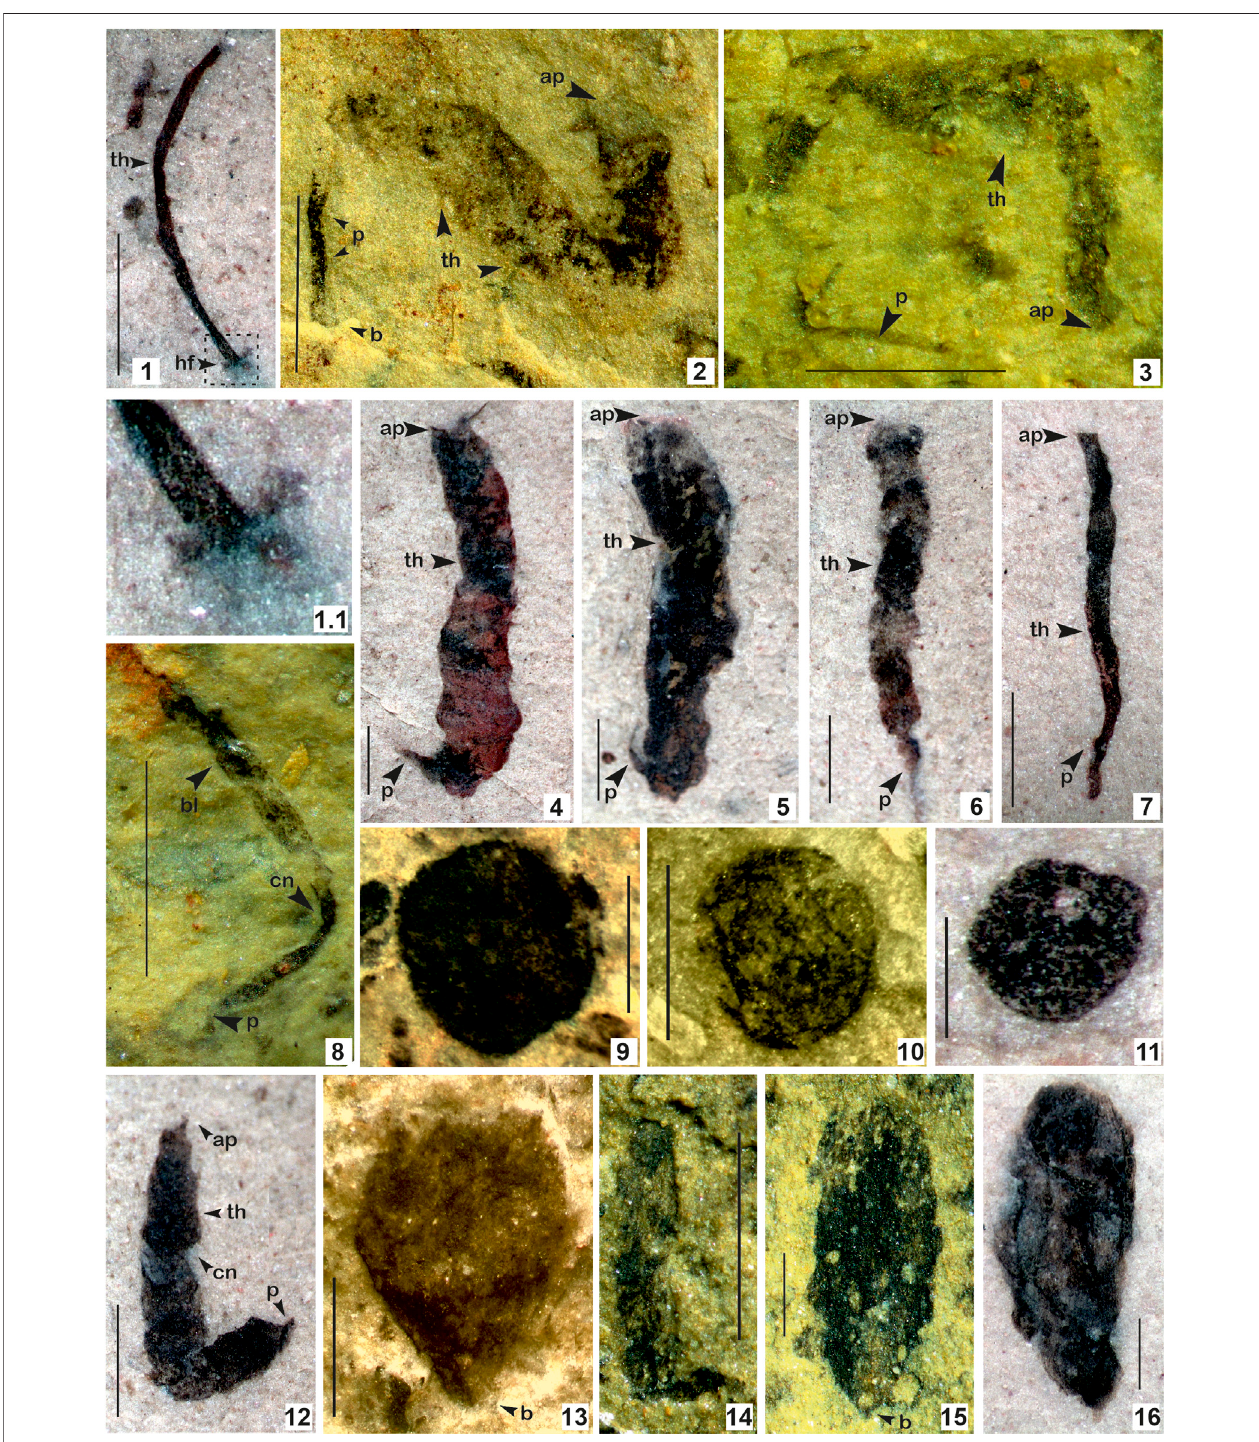
FIGURE 5 | 1 . Baculiphyca taeniata Yuan et al., 1995, emend. Xiao et al., 2002; 1.1. Enlarged view of (B) taeniata holdfast; 2 – 8, 12 . Changchengia stipitata Yan, 1997 in Yan and Liu, 1997 with distinct parastem ate base; 9 – 11 . Chuaria circularis Walcott, 1899; Vidal and Ford, 1985; 13 – 15 . Eopalmaria pristina Yan, 1995. (Arrow indicates the prominent features: ap. apex; b. base; bd. bead; th. thallus; cn. constrictions, p. parastem; hf. holdfast). 1. Specimen no. BSIP 418983; 2. Specimen no. BSIP 39782; 3. Specimen no. BSIP 39779; 4. Specimen no. BSIP 42026; 5. Specimen no. BSIP 41899. 6. Specimen no. BSIP 42038; 7. Specimen no. BSIP 42033a;8.Specimenno.BSIP39776;9.Specimenno.BSIP42022;10.Specimenno.BSIP41897;11.Specimenno.BSIP42042;12.Specimenno.BSIP42036;13. Specimen no. BSIP 42040; 14. Specimen no. BSIP 39774; 15. Specimen no. BSIP 39778; 16. Specimen no. BSIP 42030. Specimens 1, 4 – 7, 11, 12, 16 from the Bendla Dongar section and 2, 3, 8-10, 13 – 15 from the Surangi River section. Scale bar is 1.0 mm for each specimen.